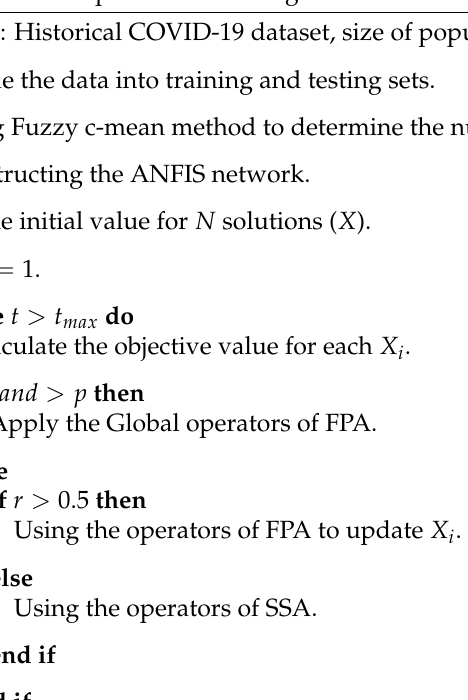
Algorithm 1 Proposed FPASSA